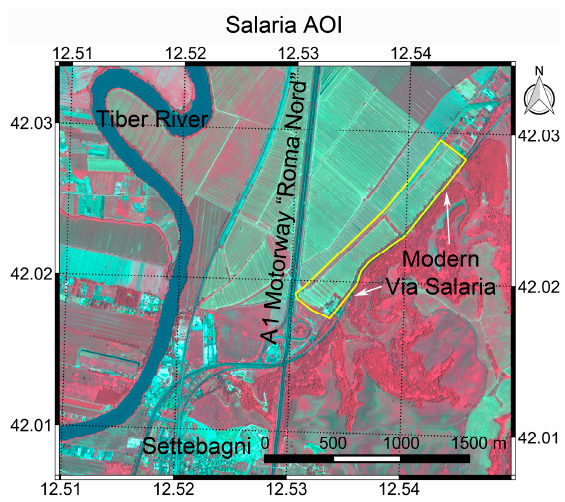
Figure 44. Pleiades image of the Salaria AOI (shown in yellow polygon) acquired on 22 May 2014, pansharpened to 0.5 m spatial resolution and displayed as a false colour composite of NIR, R and G respectively as R, G and B. Pleiades data provided by the European Space Agency.